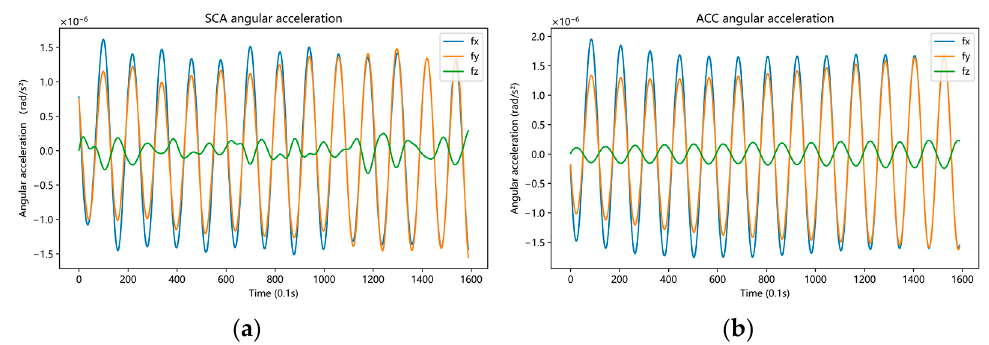
Figure 7. Angular velocity and angular acceleration of MTQ are interpolated after filtering: ( a ) MTQ angular velocity; ( b ) MTQ angular acceleration.